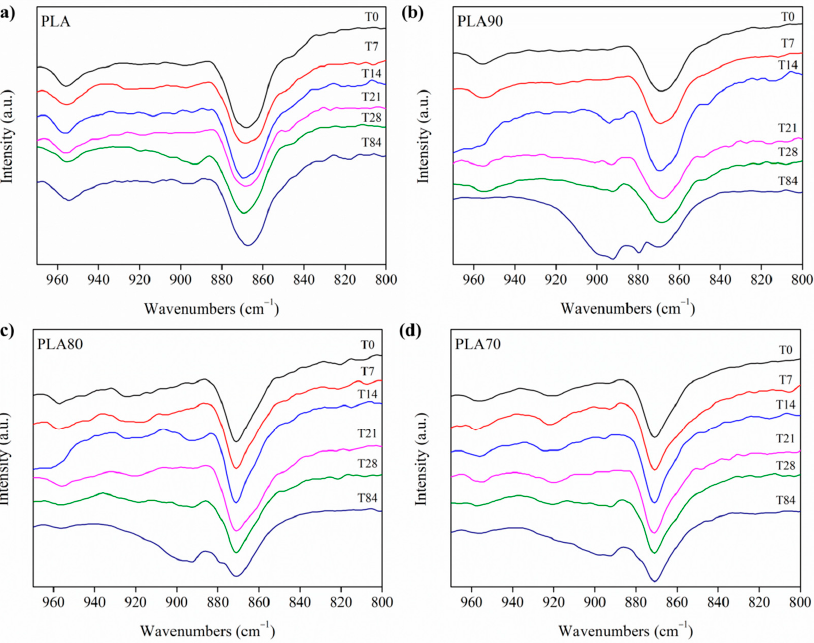
Figure 7. FTIR spectra in the 960–800 cm − 1 range for ( a ) PLA and ( b ) PLA90, ( c ) PLA80 and ( d ) PLA70 samples after 0, 7, 14, 21, 28 and 84 days of immersion in PBS.